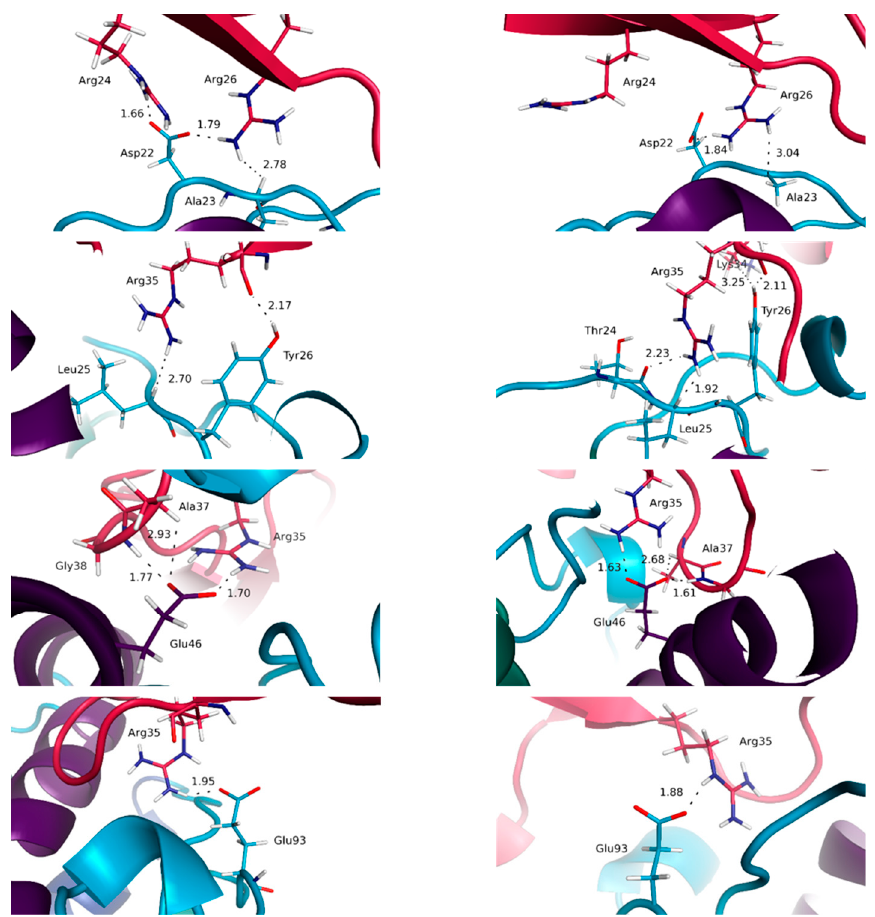
Figure 6. Representation of key interactions at the IL-15/IL-15R α interface for the full system ( left ) and the dimeric system ( right ). The distances, indicated in Å, are represented by dotted lines.